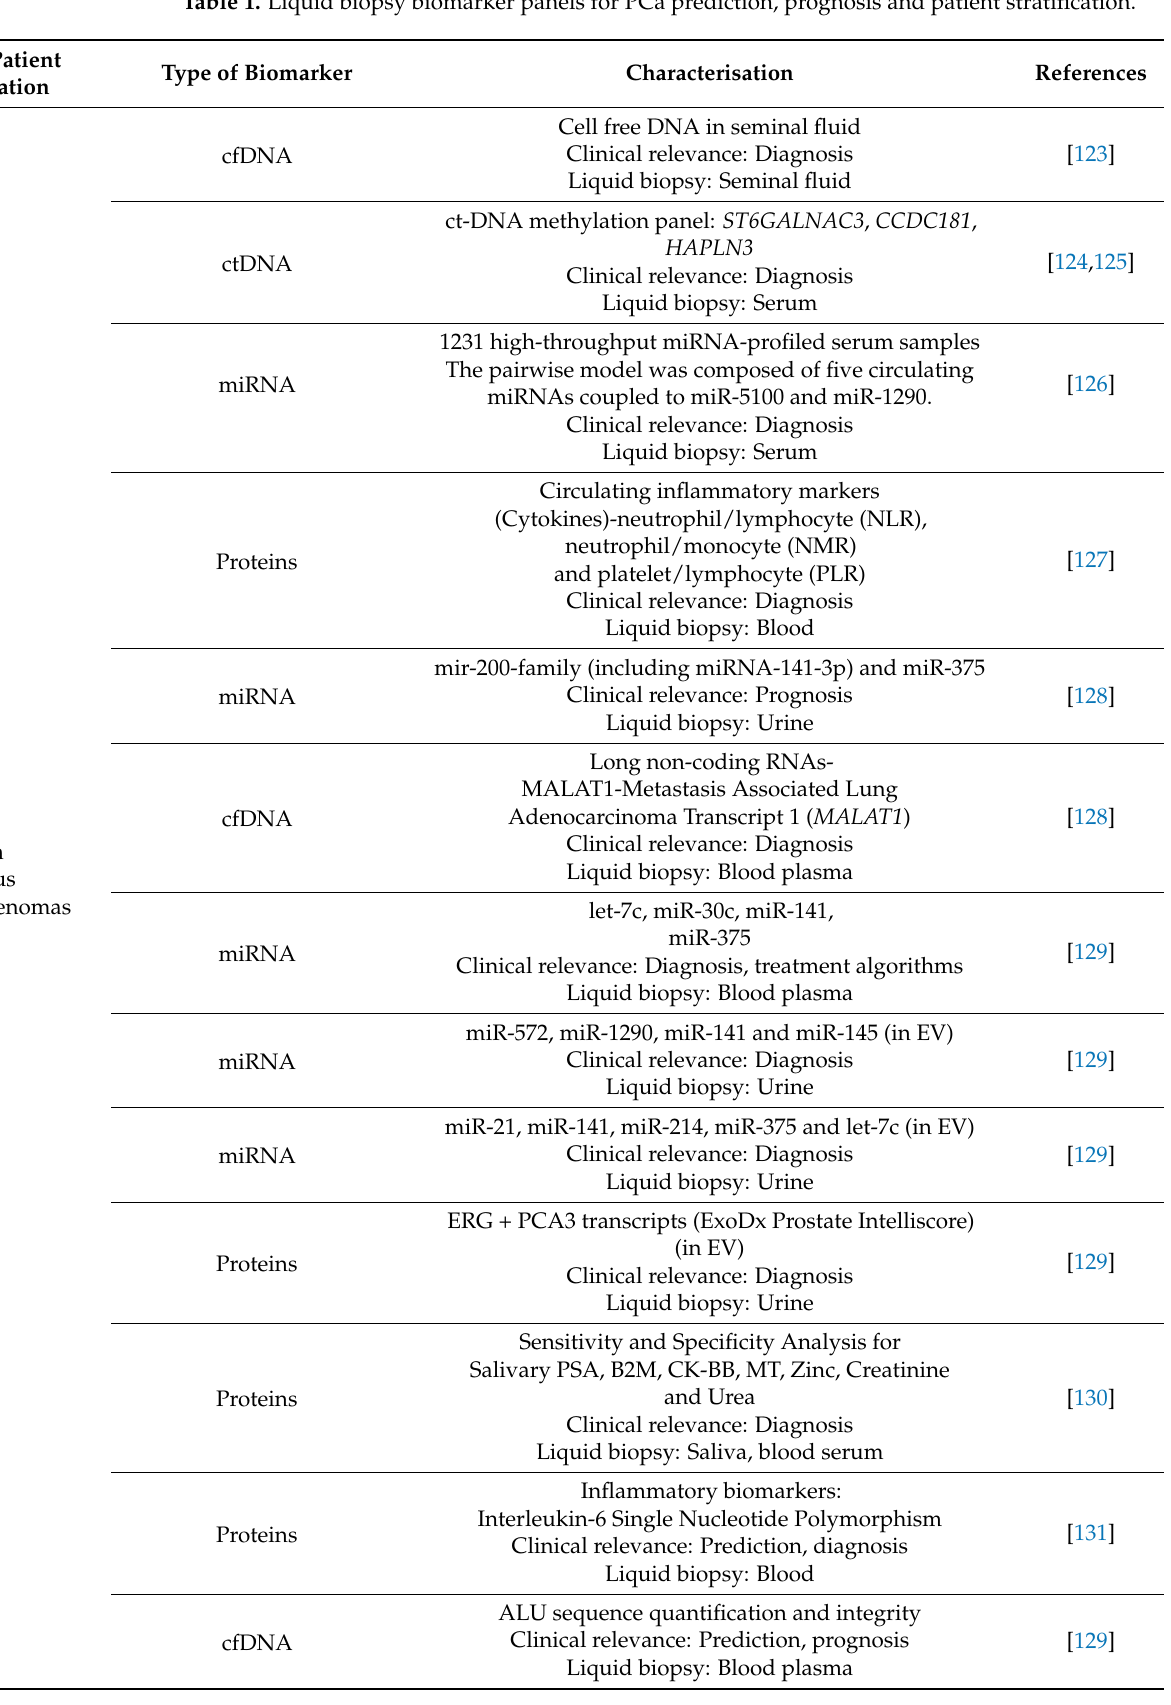
Table 1. Liquid biopsy biomarker panels for PCa prediction, prognosis and patient